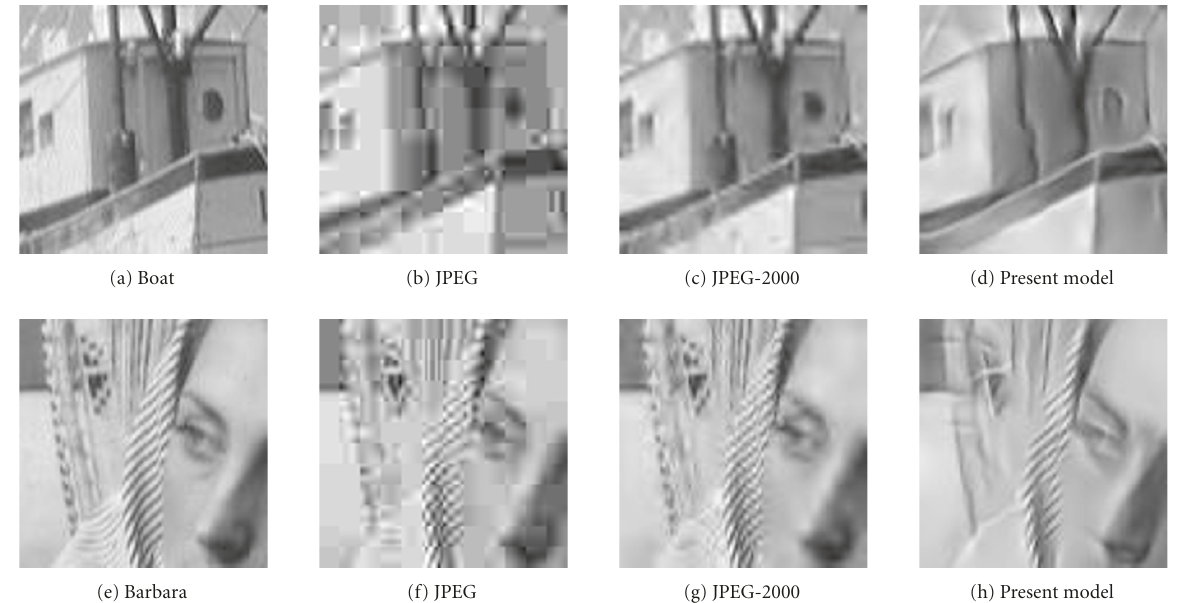
Figure 11: Compression results of “Boats” at 0 . 55 bpp and of “Barbara” at 0 . 64 bpp. (a) This 96 × 96 tile of “Boats” image contains many junctions and corners, which are di ffi cult features to be captured by the model. (b) Compression with JPEG. (c) Compression with JPEG- 2000. (d) Compression using sparse approximation and chain coding. (e) 96 × 96 tile of “Barbara” image. This image contains textures which are also di ffi cult features to be encoded by the model. (f) Compression with JPEG. (g) Compression with JPEG-2000. (h) Compression using the proposed model.